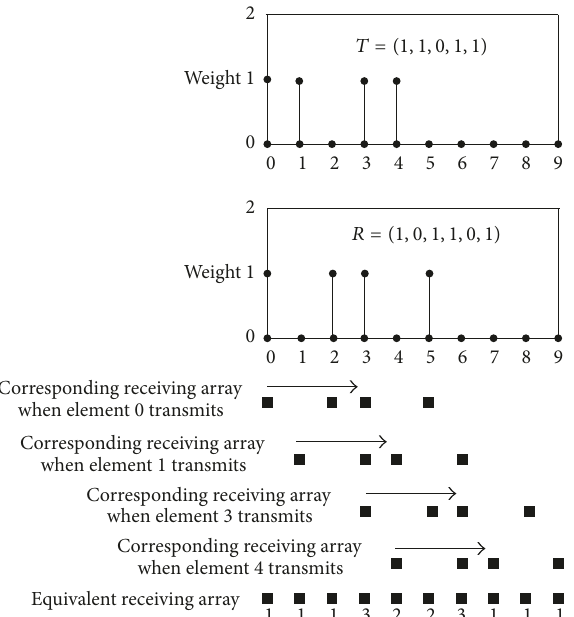
Figure 3: Spatial convolution of MIMO array.